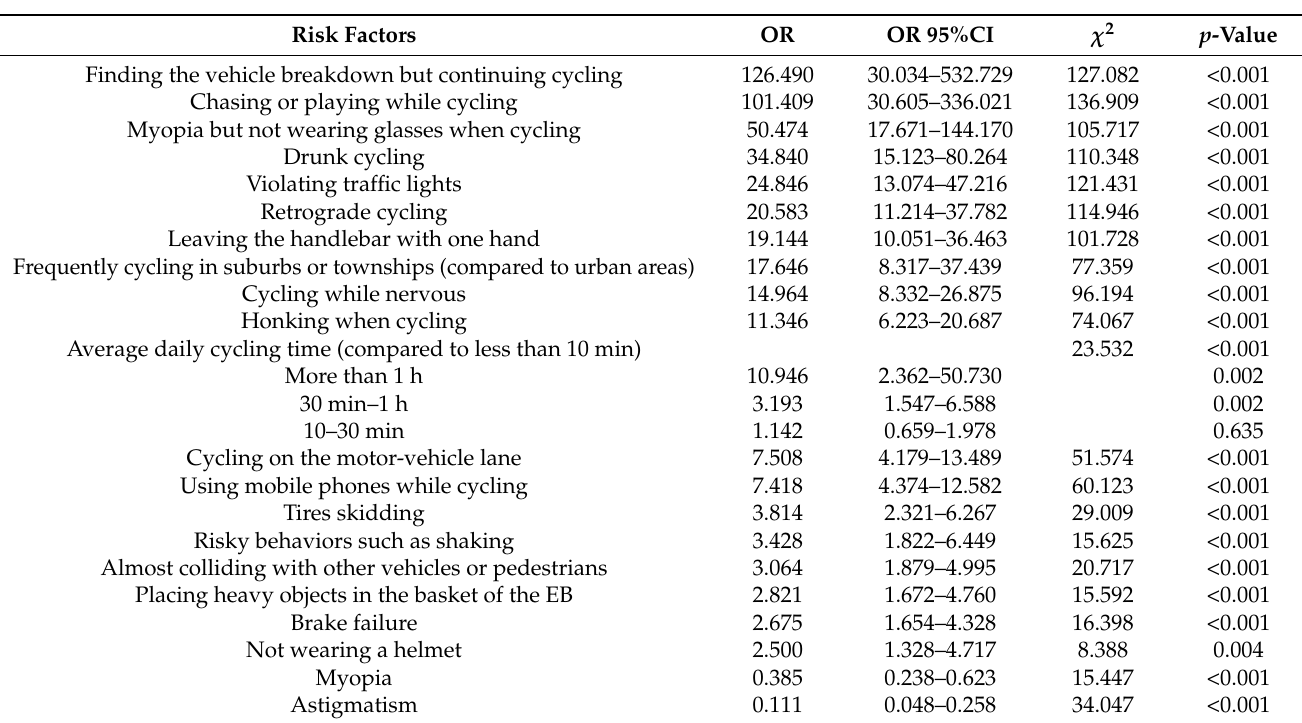
Table 2. Univariable analysis of risk factors of